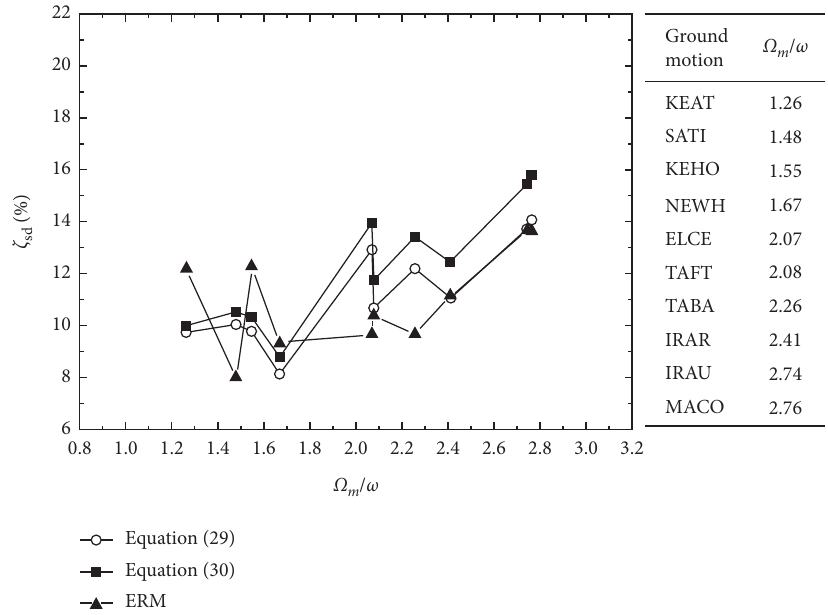
Figure 15: Comparison of the calculation results of equations (29) and (30) and the ERM.